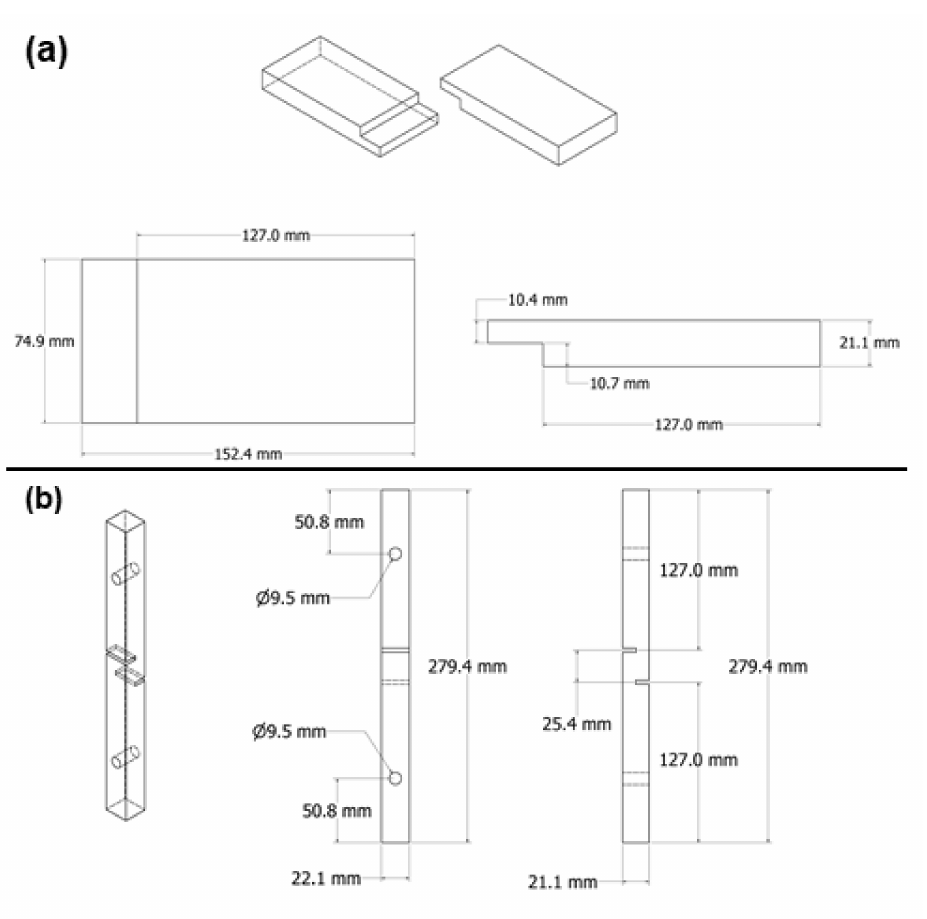
Figure 2. Specimen fabrication and geometry. ( a ) Douglas-fir #1 and better notched board before adhering. ( b ) Final dimensions of the specimens